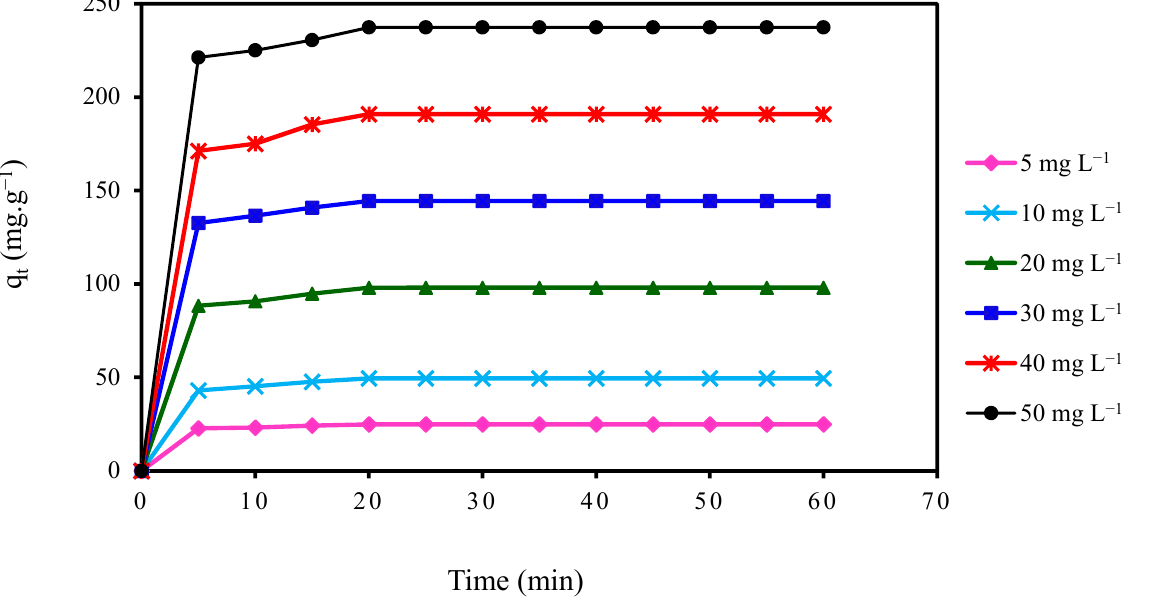
Figure 2. Effect of contact time on dicamba adsorption. Dosage: 20 mg; concentration, 5–50 mg L − 1 ; temp, 40 °C; equilibrium time, 25 min and 150 rpm. Table 2. Adsorption kinetics parameters for the removal of dicamba.